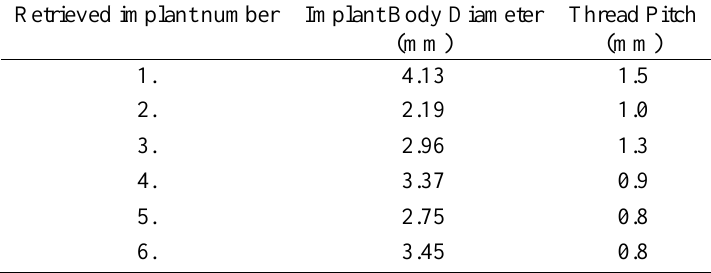
Table 2. Diameter and thread pitch of the different retrieved implants.